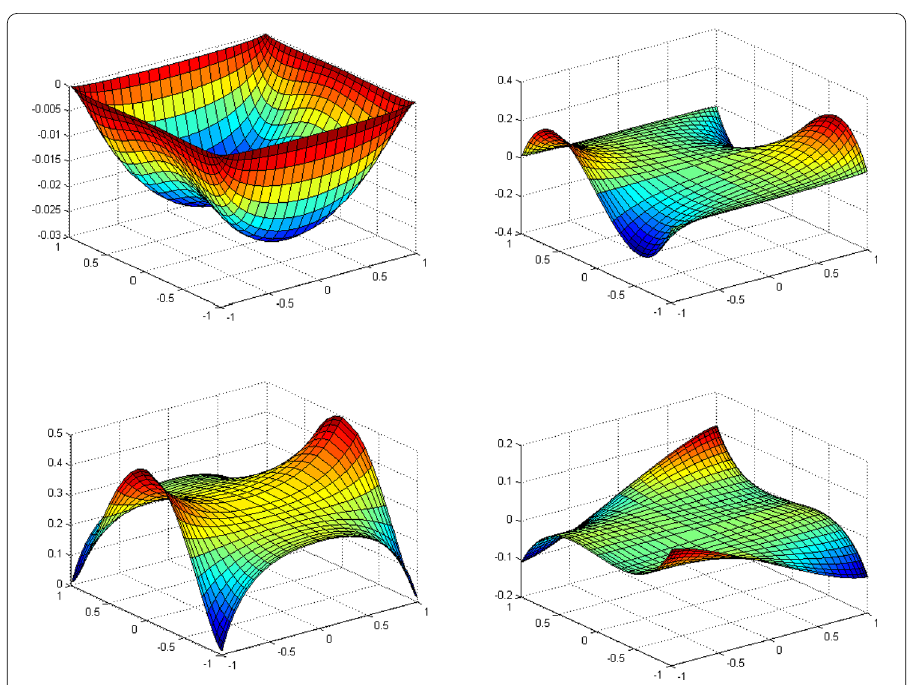
Figure 4 The solution ( τ , u x , u y , p ) for the data ( f , g ) defined in